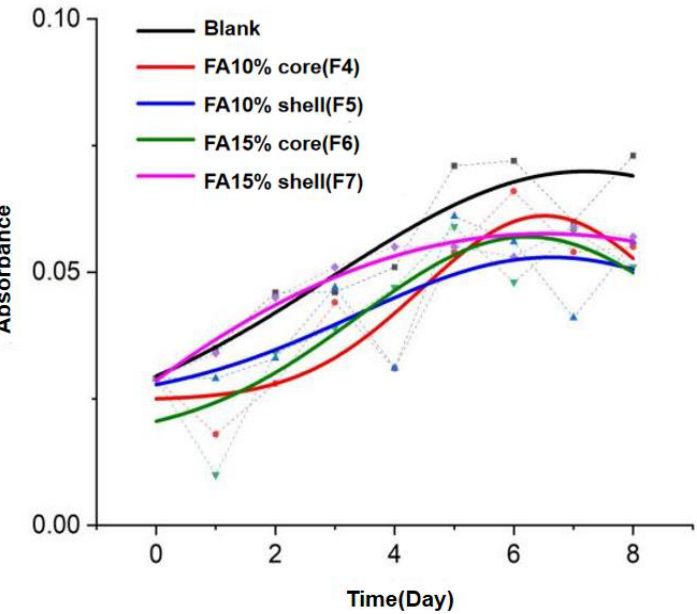
Figure 15. Qualitative analysis of the browning rate of apple slices after ancillary fruit packaging.